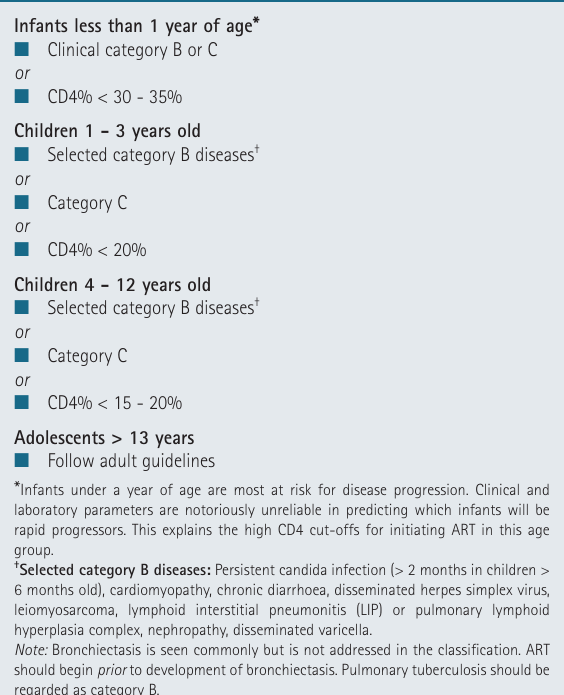
TABLE III. INDICATIONS FOR STARTING ART IN